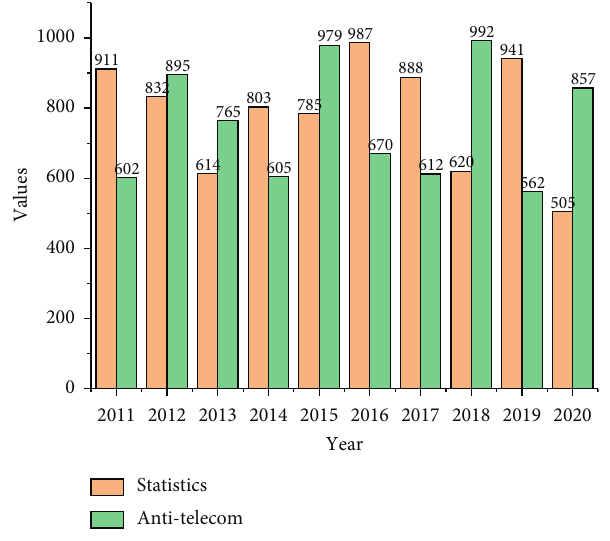
Figure 7: The decline of “piggy bank” telecom network fraud data in the first quarter of X